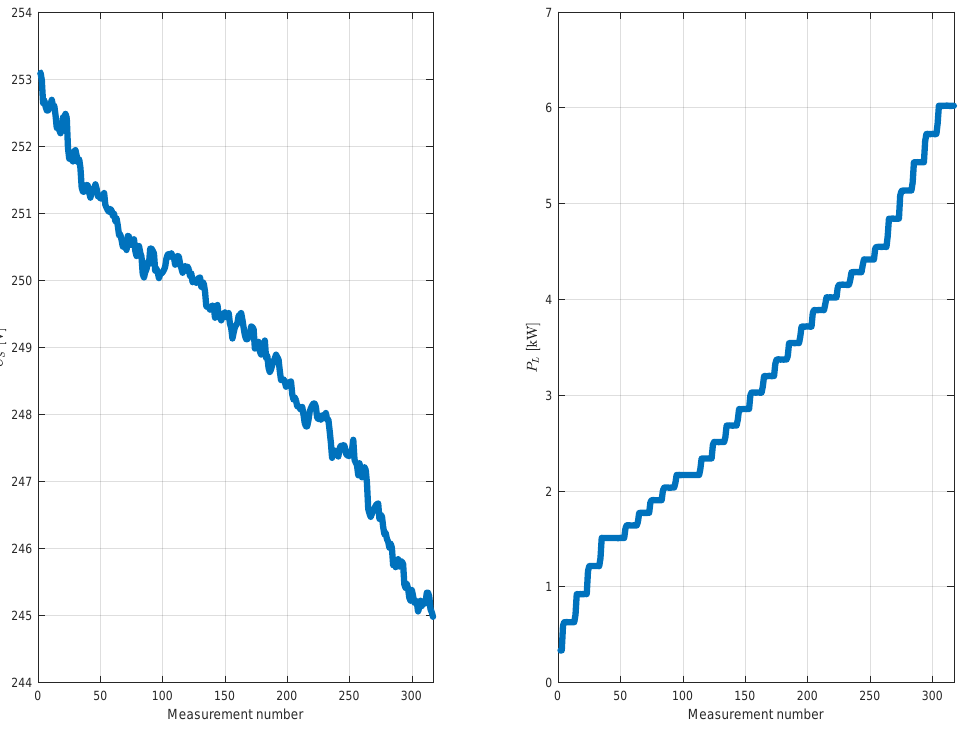
Figure 17. Results from test laboratory environment for increasing P L .